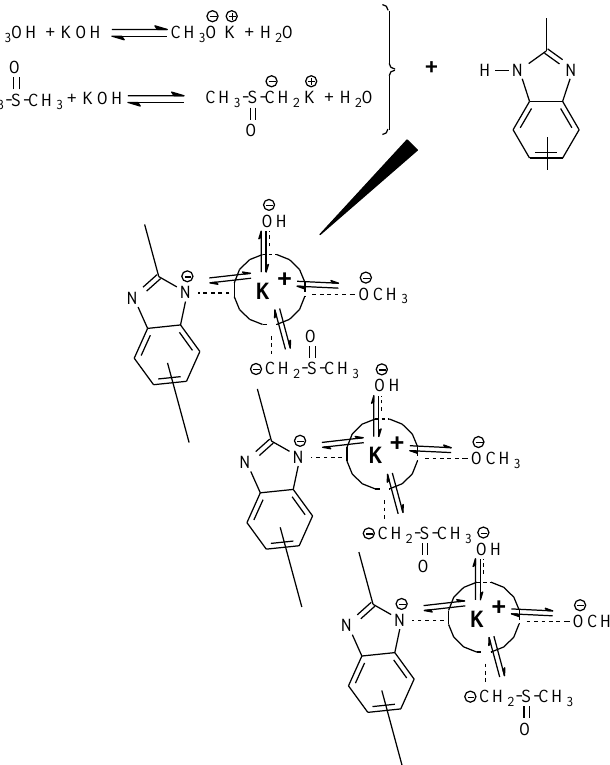
Figure 1. ABPBI dissolution scheme in a complex solvent.